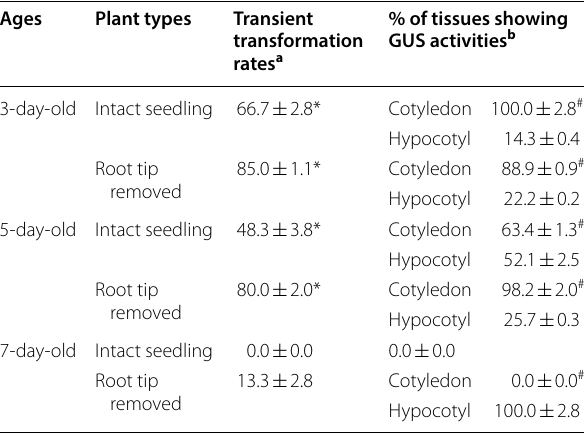
Table 1 Transient transformation rates of A. tumefaciens EHA105 strain harboring the pBISN1 plasmid in ice plant seedlings and distribution (%) of GUS staining in ice plant seedlings of different